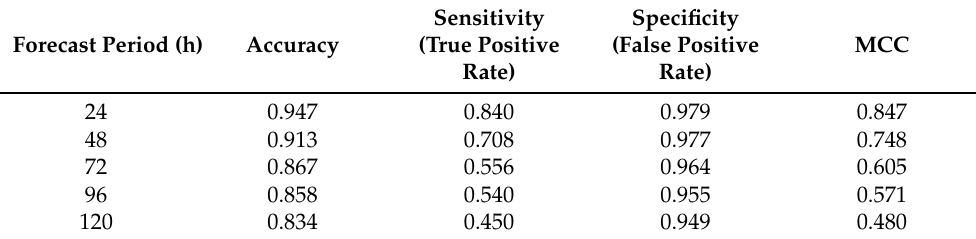
Figure 8. Confusion matrices for salinity forecasted by using the selected ANN combined model with forecast periods from 24 h to 120 h. Table 5. The forecast performance evaluated through the confusion